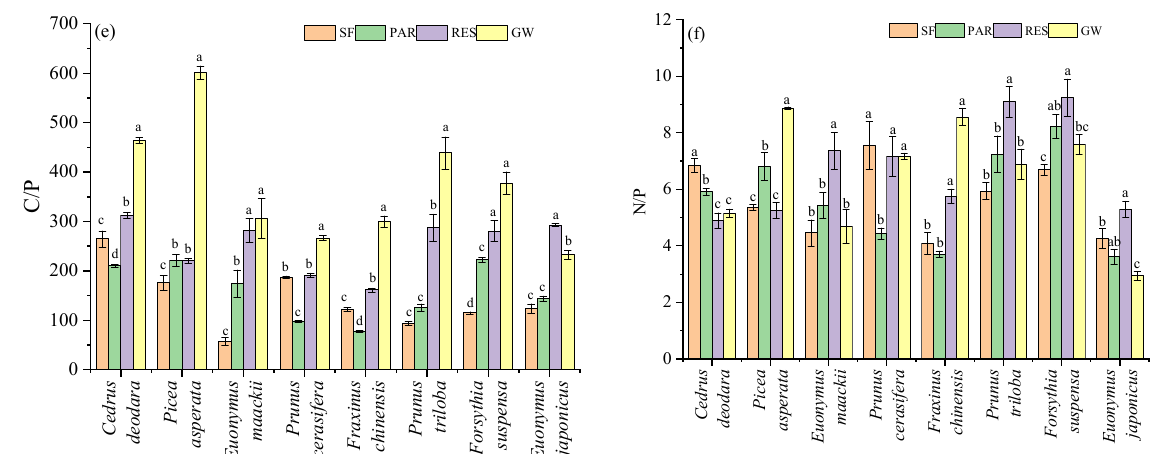
Figure 4. Characteristics of the leaf nutrient traits of eight plants in four urban green space environ- ments. SF = sport field; PAR = park; RES = residential green space; GW = greenway. Different letters above the bars indicate significant differences among four urban green spaces: ( a ) leaf carbon content (LCC); ( b ) leaf nitrogen content (LNC); ( c ) leaf phosphorus content (LPC); ( d ) leaf carbon/nitrogen ratio(C/N); ( e ) leaf carbon/phosphorus ratio (C/P); ( f ) leaf nitrogen/phosphorus ratio(N/P).